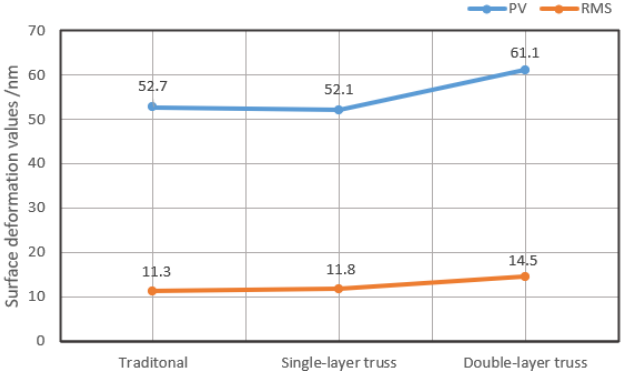
Figure 6. Surface deformation results in Figure 5 .